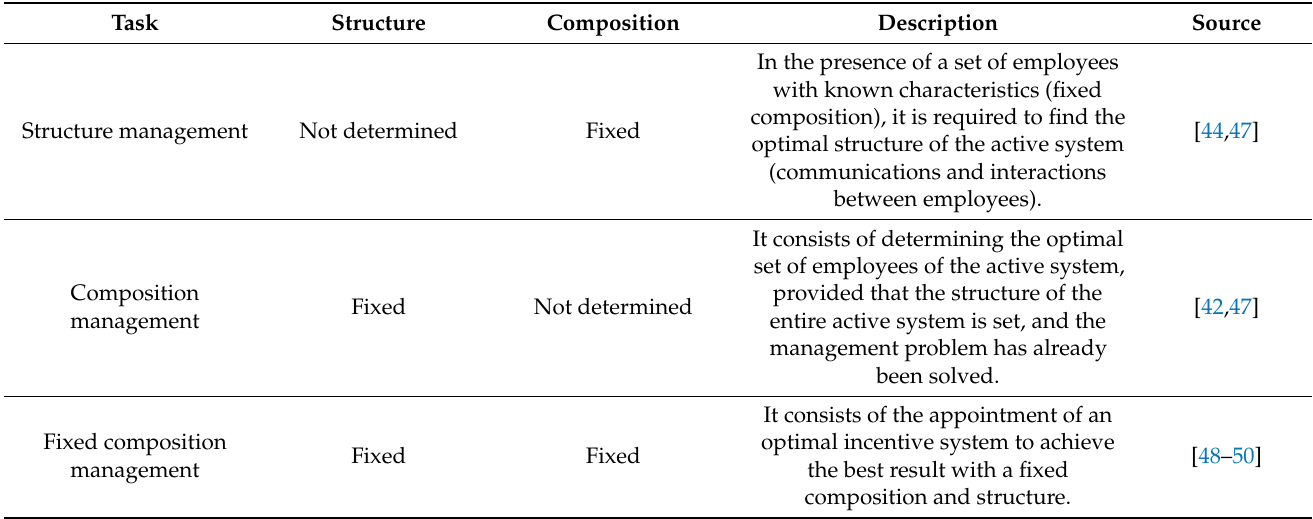
Table 2. Analysis of the tasks of human resource management.